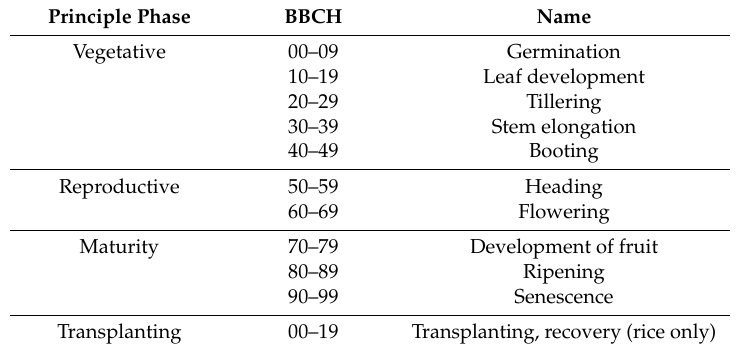
Table 1. Description of the phenology of cereals using the BBCH Scale.